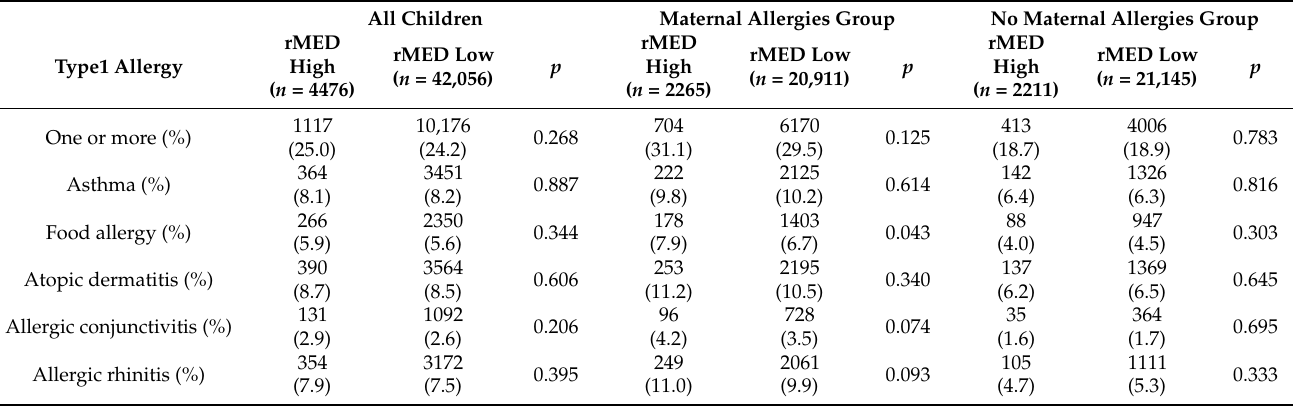
Table 3. Comparison of allergic outcomes between the two rMED groups. All Children Maternal Allergies Group No Maternal Allergies Group